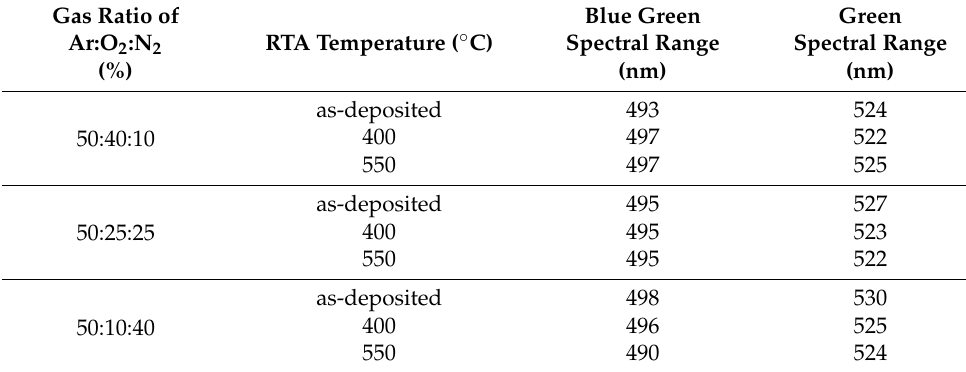
Table 3. The positions of the PL Gaussian emission peaks of the ZnO:N films.